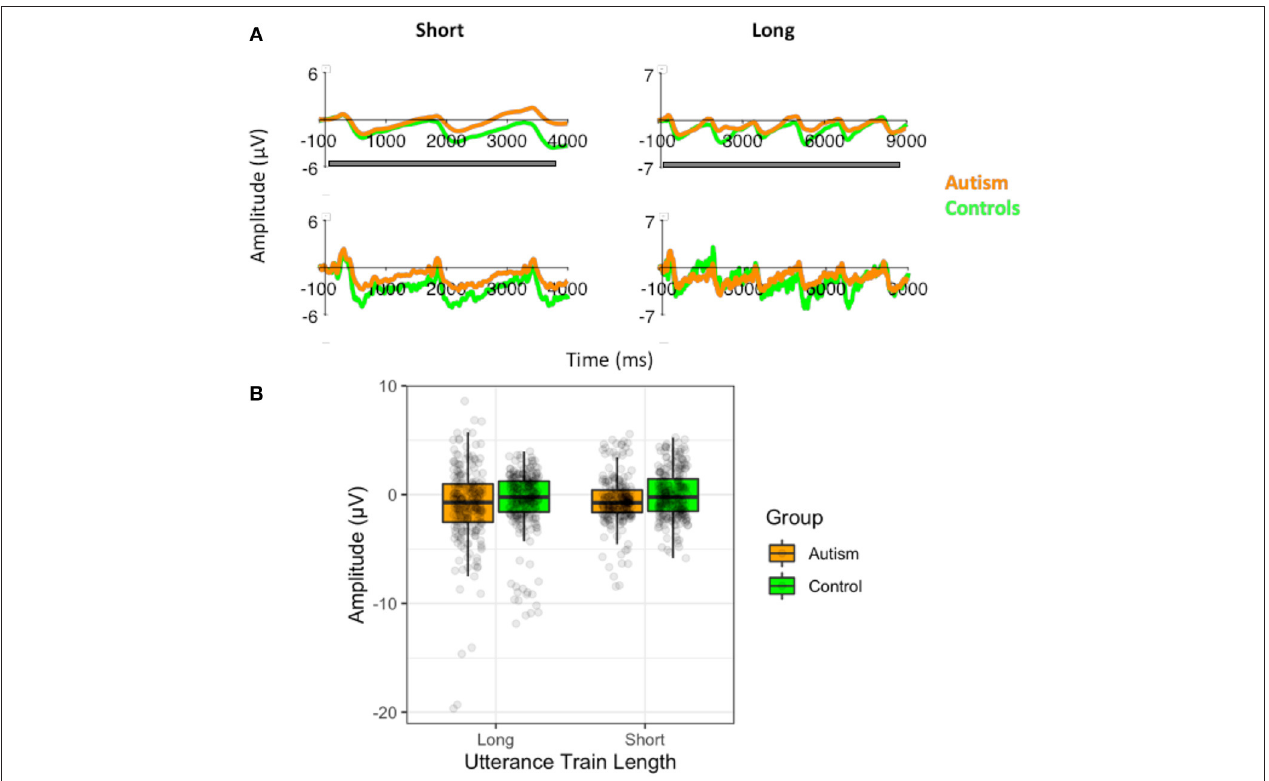
FIGURE 9 | (A) Waveforms to the short (3) standard utterance trains and the long standard utterance trains (6) filtered at 1.5Hz for the analysis of the slow-wave (top) and without the filtering (i.e., the original filtered data; bottom), shown separately for individuals with autism and neurotypical controls. Both versions of the filtered waveforms are shown to illustrate the slow-wave that was analyzed and how it arose from the original data used to calculate the P3. The gray bar indicates the window use for the slow-wave analysis. (B) Amplitudes of the slow-waves for the long and the short standard utterance trains shown separately for individuals with autism and neurotypical